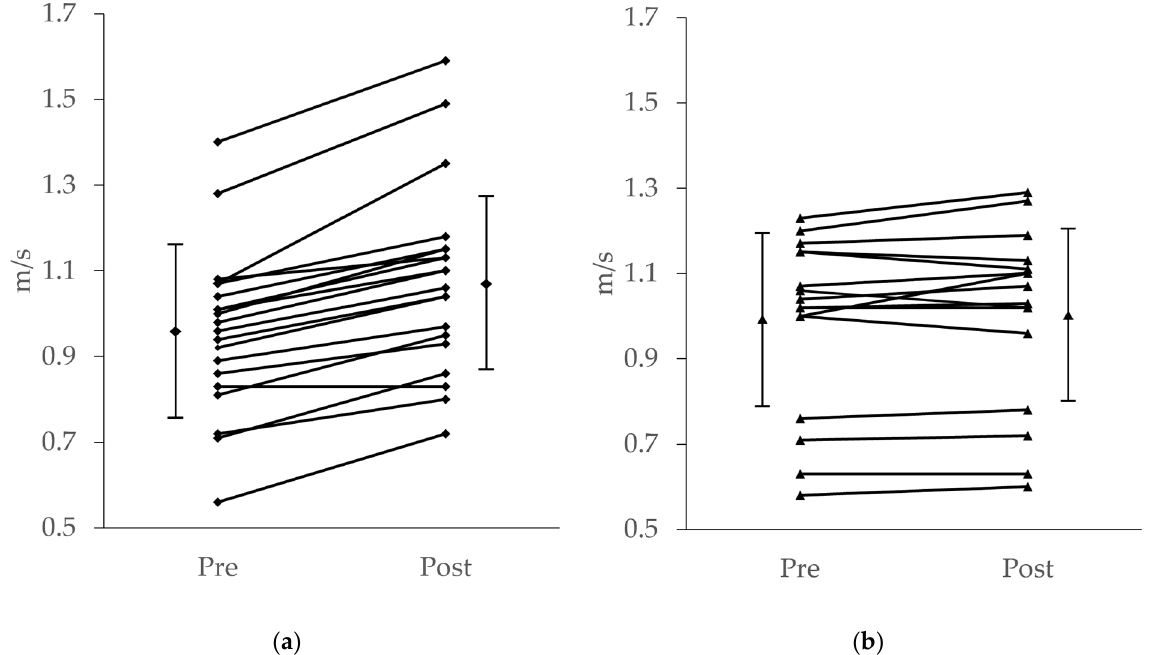
Figure 3. Gait speed of SSTT group ( a ) and control group ( b ) before and after the intervention. Group average and standard deviation (vertical bars). Individual data (solid lines). Table 2. Comparison of gait function and lower extremity muscle strength between SSTT and con- trol groups.